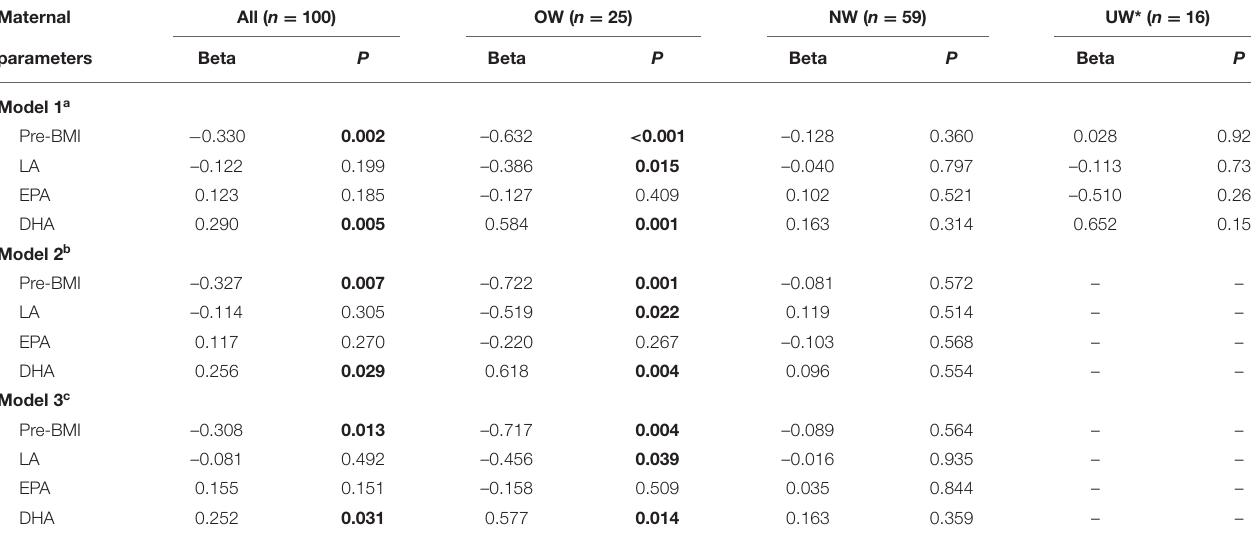
TABLE 4 | Linear regression analysis on the correlation of maternal parameters and fetal cord plasma DHA percentage. Maternal All ( n = 100) OW ( n = 25) NW ( n = 59) UW* ( n =